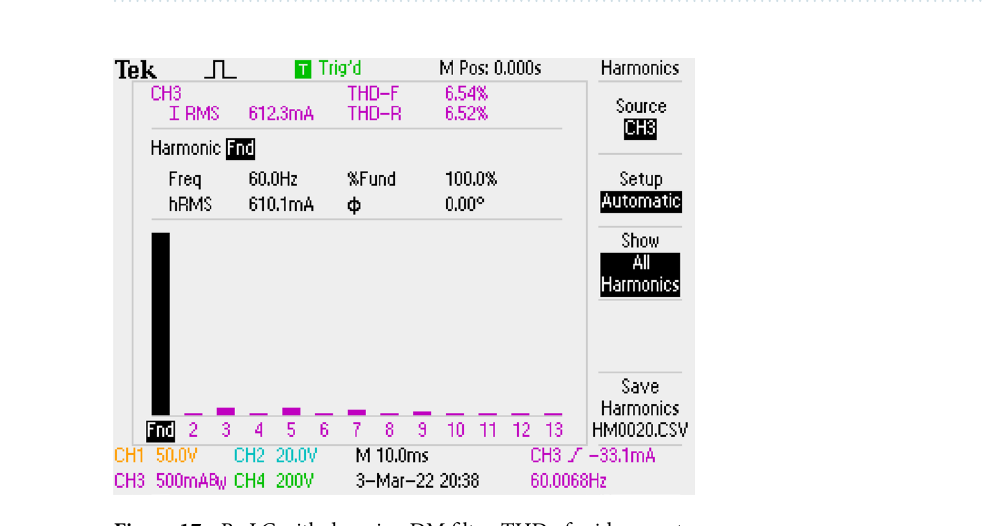
Figure 17. By LC with damping DM filter, THD of grid current.